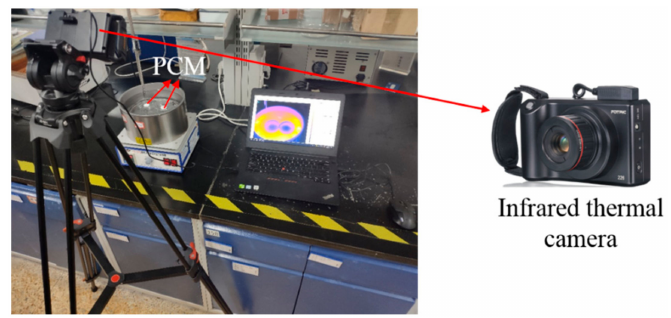
Figure 1. The equipment of heat storage capacity determination.